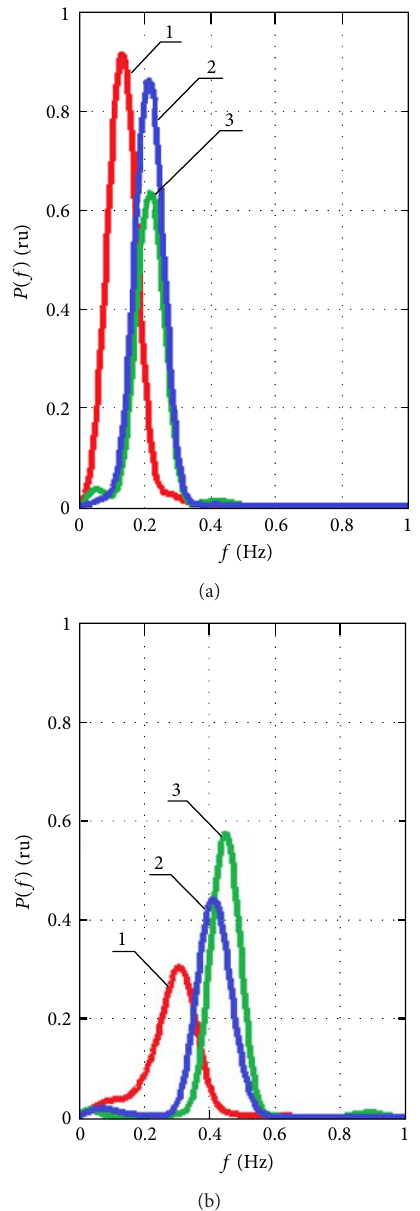
Figure 6: Typical CPSDFs for couples of BRL and RPG signals (1, 2, 3: subject numbers; (a): spontaneous breathing; (b): rapid